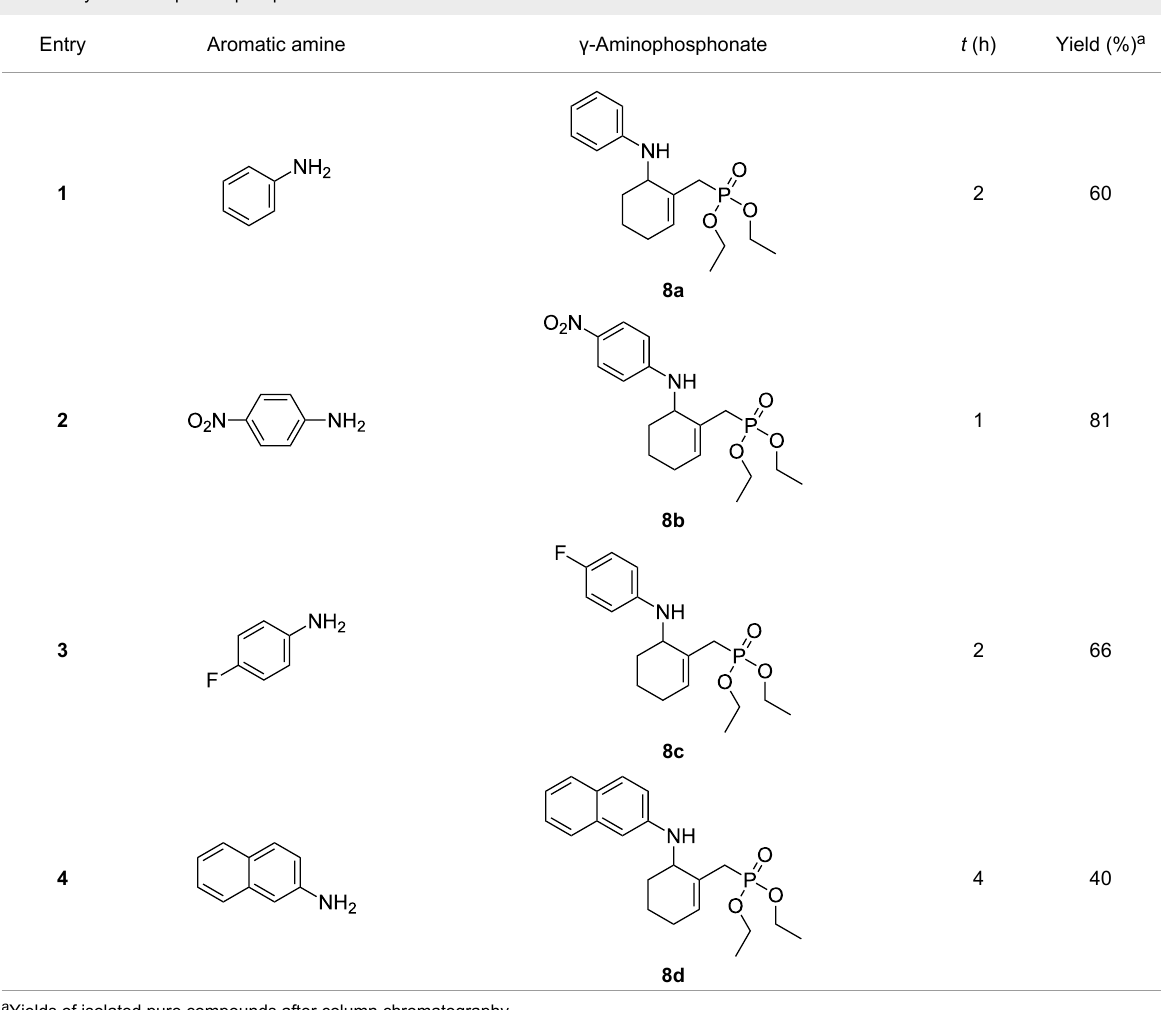
Table 5: Synthesis of γ -aminophosphonates 8a–d from acetate 7